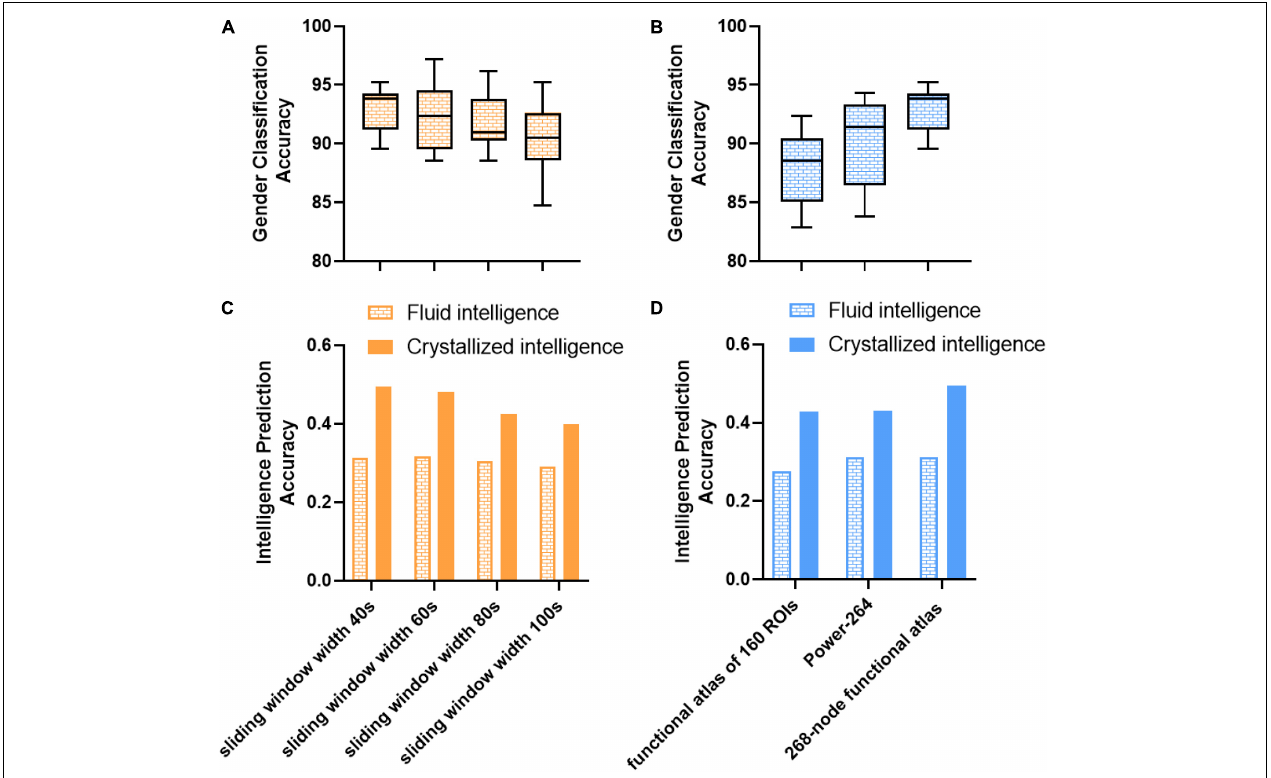
FIGURE 6 | Impact of parcellation scheme and sliding window width on gender classification and intelligence prediction performance in control analysis. (A) Impact of sliding window width on gender classification. (B) Impact of parcellation scheme on gender classification. Box refers to median with 25 and 75th percentiles, and whiskers represent minimal to maximal values. (C) Impact of sliding window width on intelligence prediction. (D) Impact of parcellation scheme on intelligence prediction. The accuracy of intelligence prediction is evaluated with the Pearson’s correlation between predicted and observed intelligence scores of all subjects across all